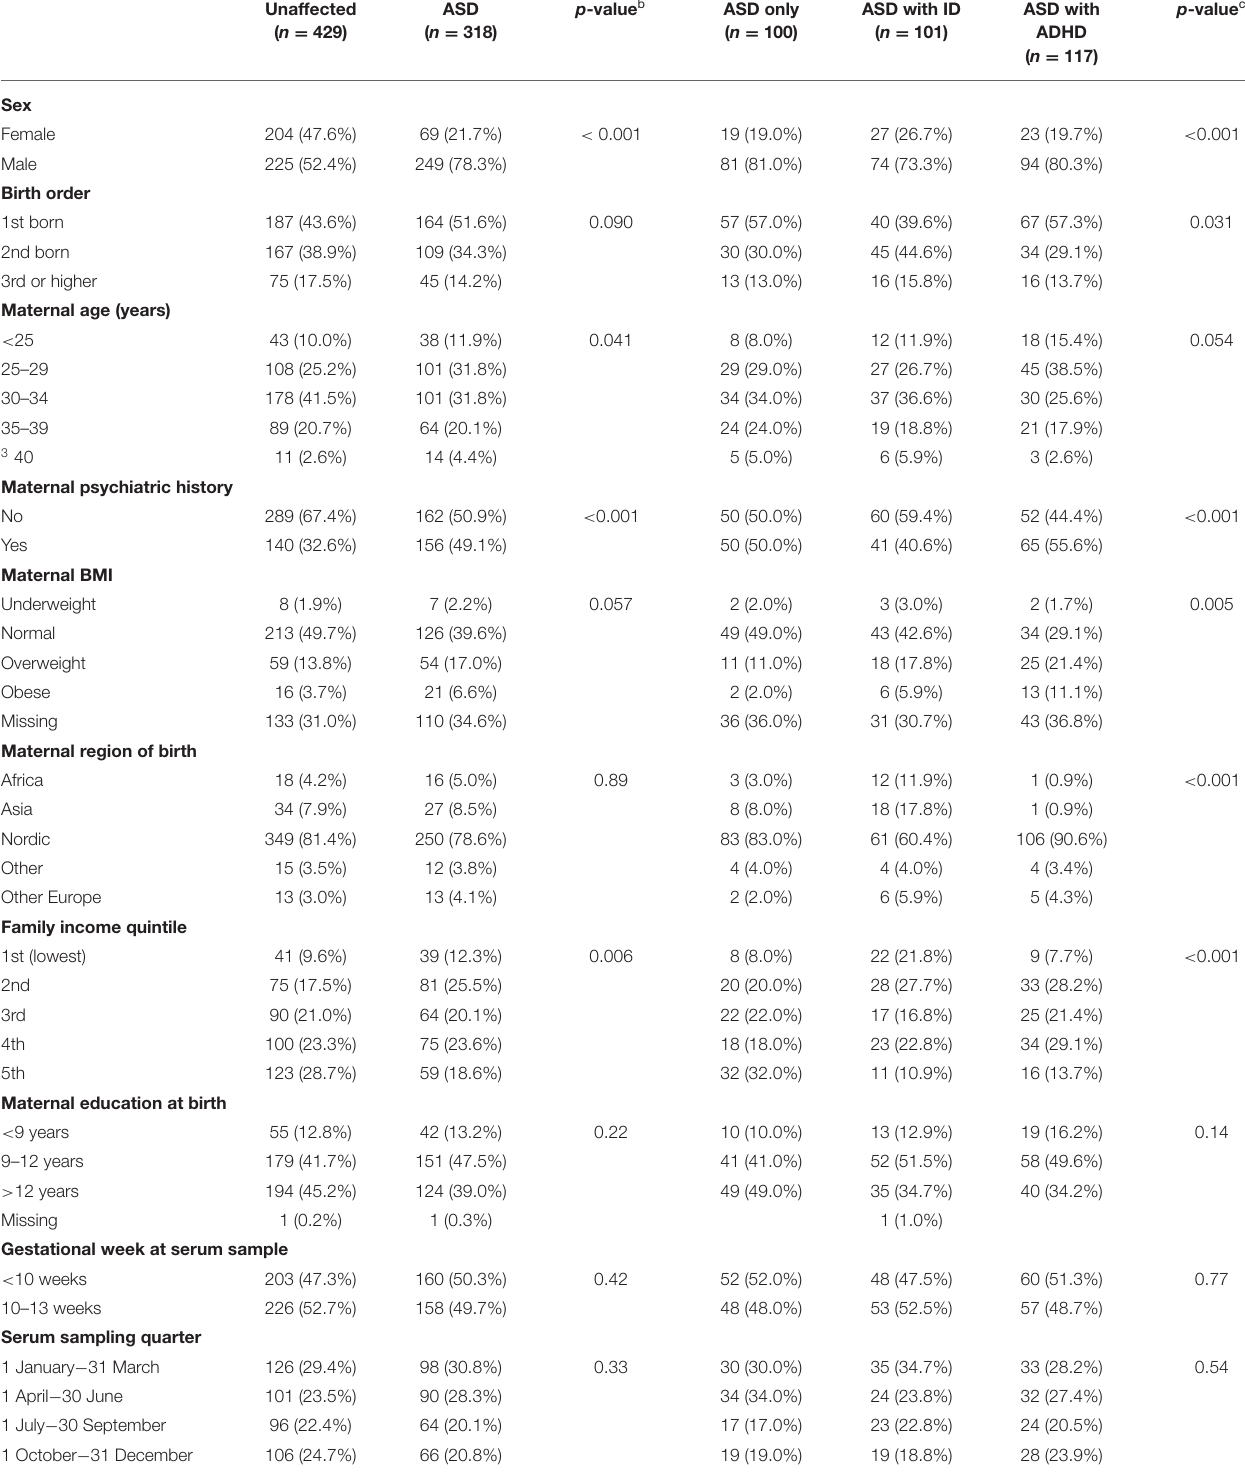
TABLE 1 | Characteristics of individuals diagnosed with ASD and unaffected individuals in the study sample a